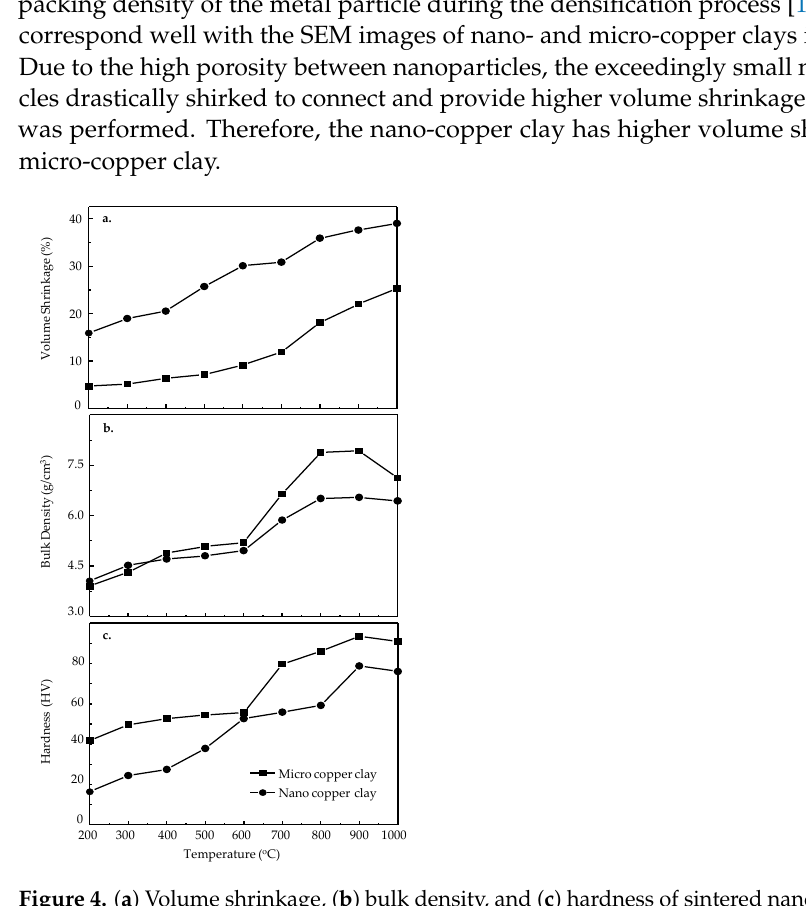
Figure 4. ( a ) Volume shrinkage, ( b ) bulk density, and ( c ) hardness of sintered nano- and micro-copper clays with different heating temperatures.